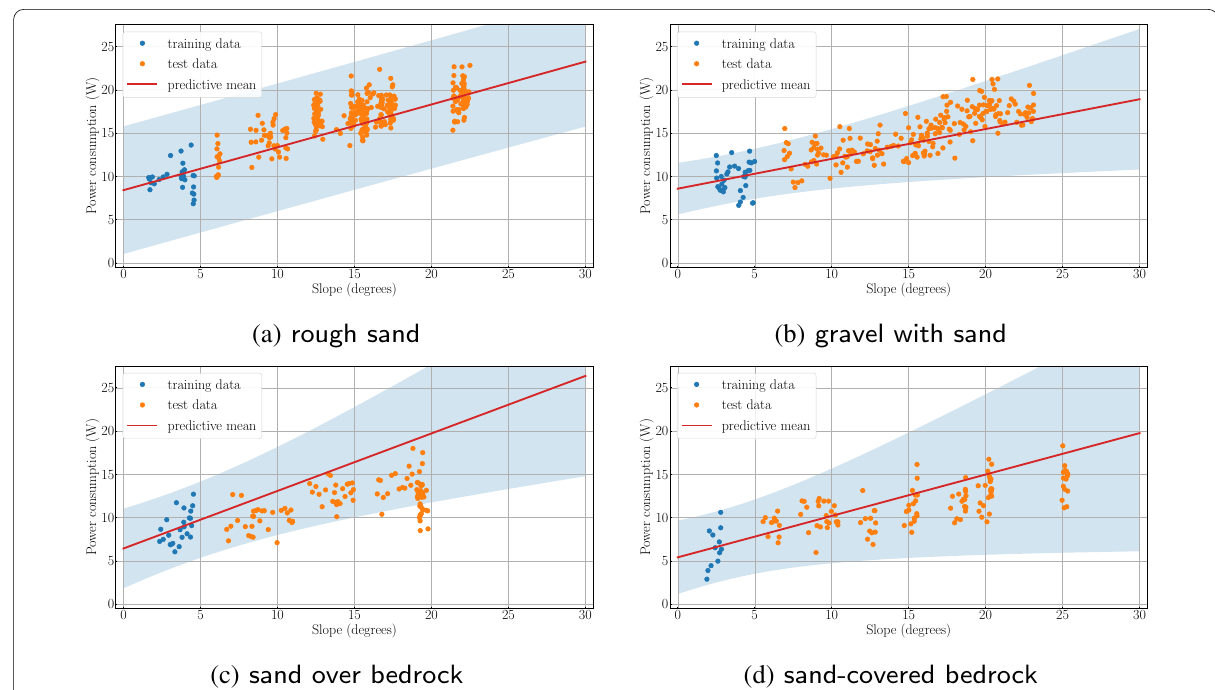
Fig. 16 Results of Evaluation 5. Prediction of power consumption for the four target domains with MS-TGPR-based approach. The red curve represents the predictive mean, while the blue-shaded area represents 2-standard deviation around the mean. The blue and orange points represent the training and test data, respectively